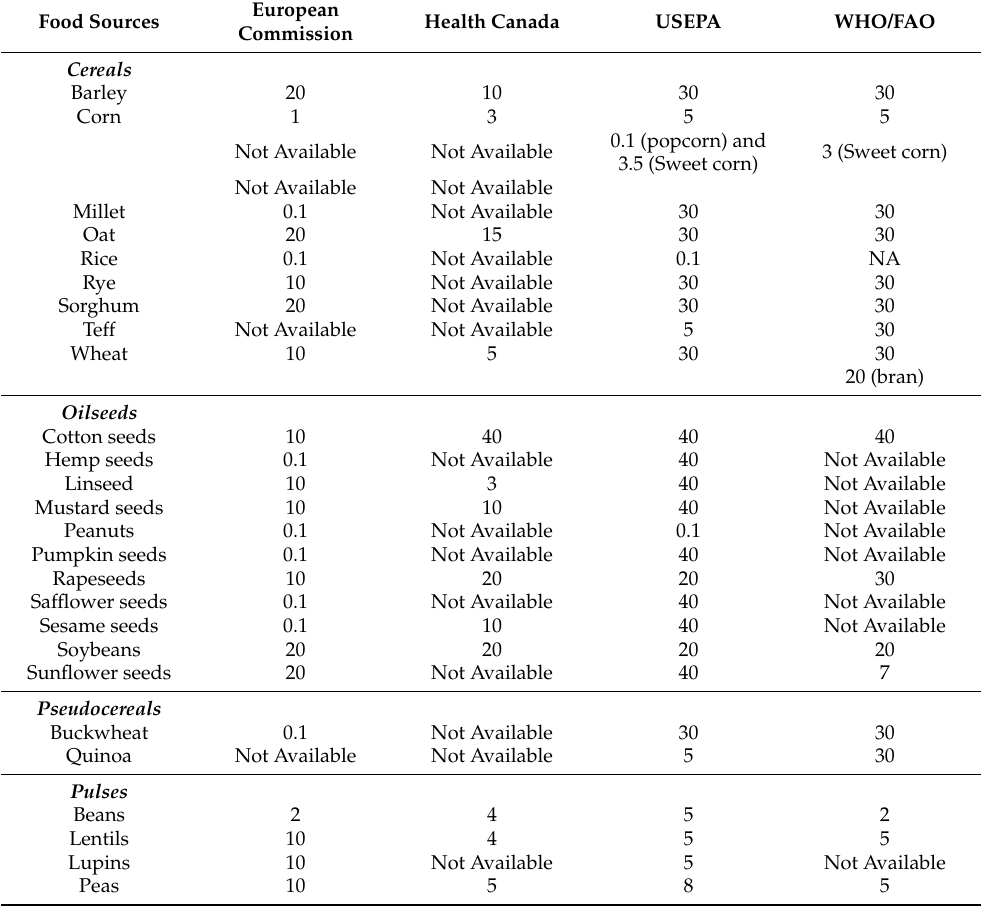
Table 4. Maximum permissible glyphosate residue (mg/kg) in grains placed by different agencies. European Food Sources Health Canada USEPA Commission Cereals